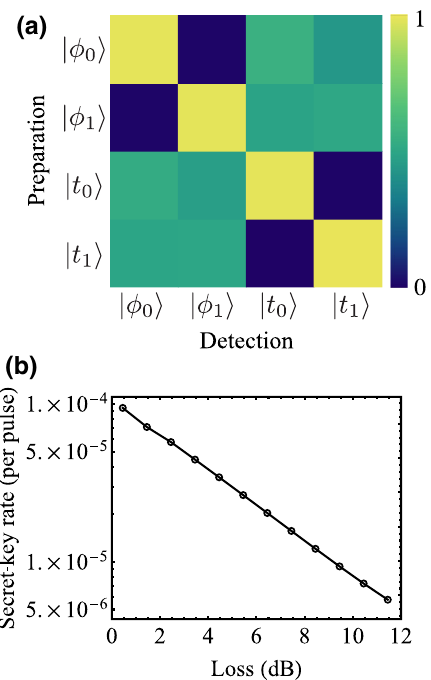
FIG. 6. QKD results. (a) The probability-of-detection matrix. The rows correspond to different prepared input time-bin states and the columns correspond to different measured output states. (b) The secret-key rate as a function of the channel